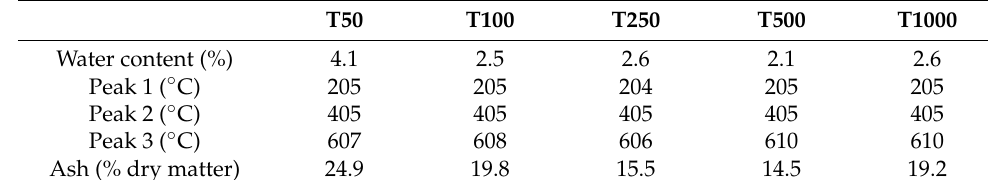
Table 1. Thermal properties of the tomato plant particle samples.